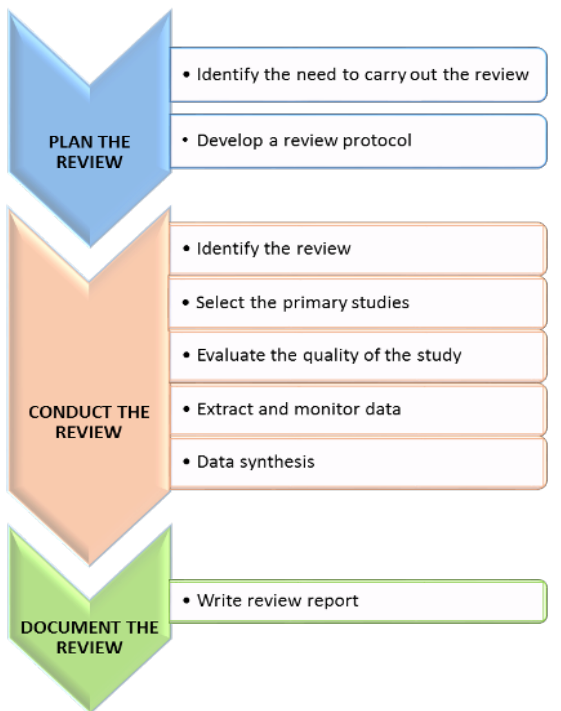
Figure 2. Systematic literature review methodology based on Kitchenham